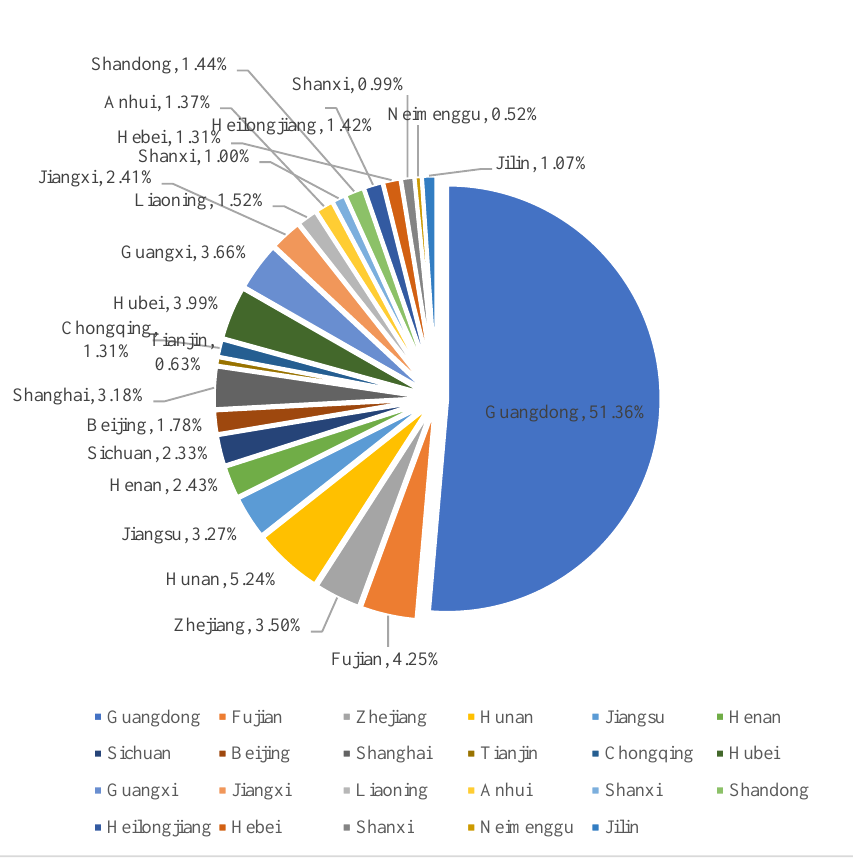
Figure 3. Inbound Chinese tourists by major provinces and cities from 2017 to 2019.